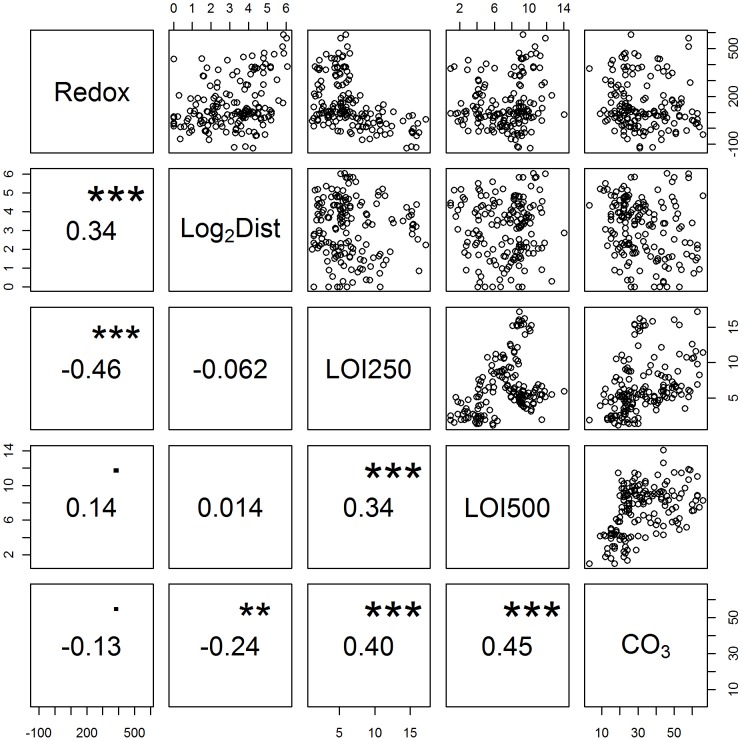
Bivariate correlations between response (Redox) and predictors across all sites.Log2Dist – log2 distance (m), LOI250/500 - loss on ignition at 250 and 500°C (%), CO3 – carbonate content (%). Correlations (font size scales with significance) and significances, are shown in the lower half of the plot. Significance of correlations key: *** - P<0.001, ** - P<0.01, * - P<0.05. N = 159.